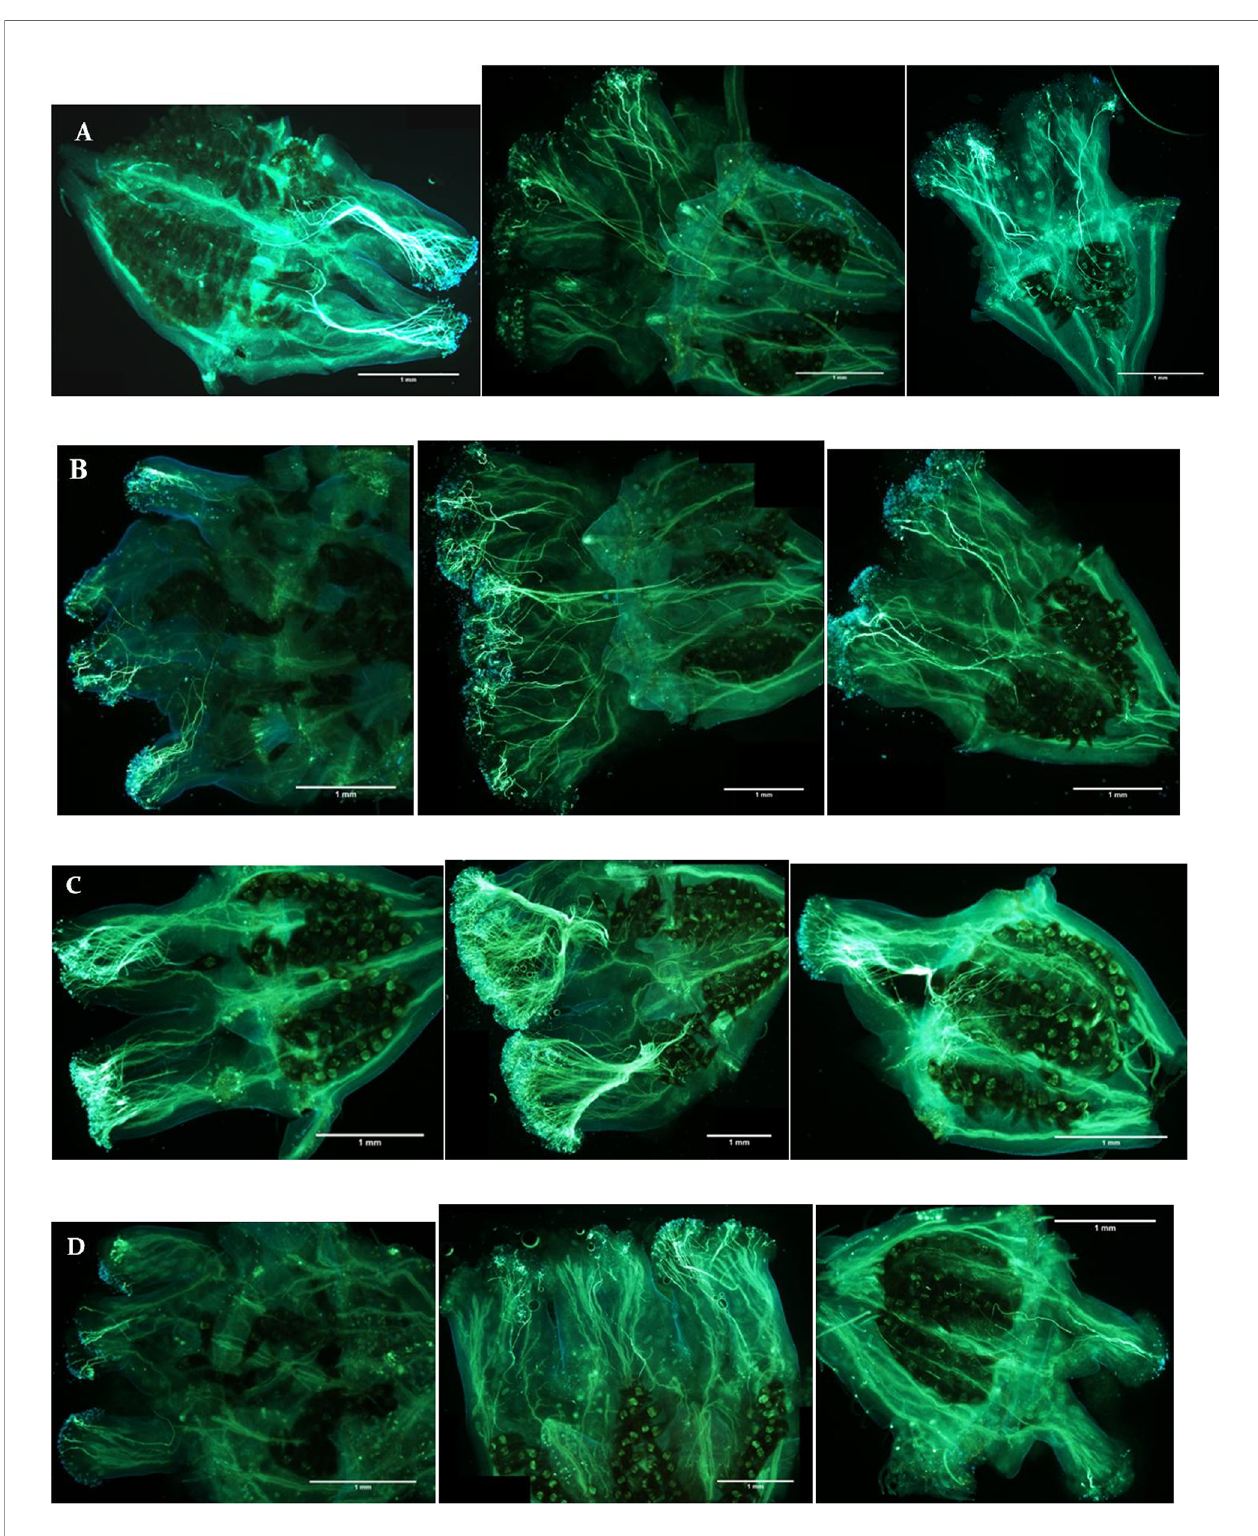
FIGURE 2 | Stained pistils showing pollen tube growth from (A) 2x × 2x, (B) 2x × 3x, (C) 3x × 2x, and (D) 3x × 3x controlled crosses of Hydrangea macrophylla collected 24 h (left), 48 h (center), and 72 h (right) post-pollination. Crosses shown from top to bottom are: “ Decatur Blue ” x “ Oakhill ” , “ Decatur Blue ” x “ Kardinal ” , “ Kardinal ” x “ Decatur Blue ” , and “ Taube ” x “ Kardinal ” . Pistils were fi xed, rinsed, hydrolyzed, stained with decolorized aniline blue, and placed on microscope slides. Slides were observed after 1 h using an Olympus BX-60 compound microscope with an Olympus Q Color 5 digital camera for image